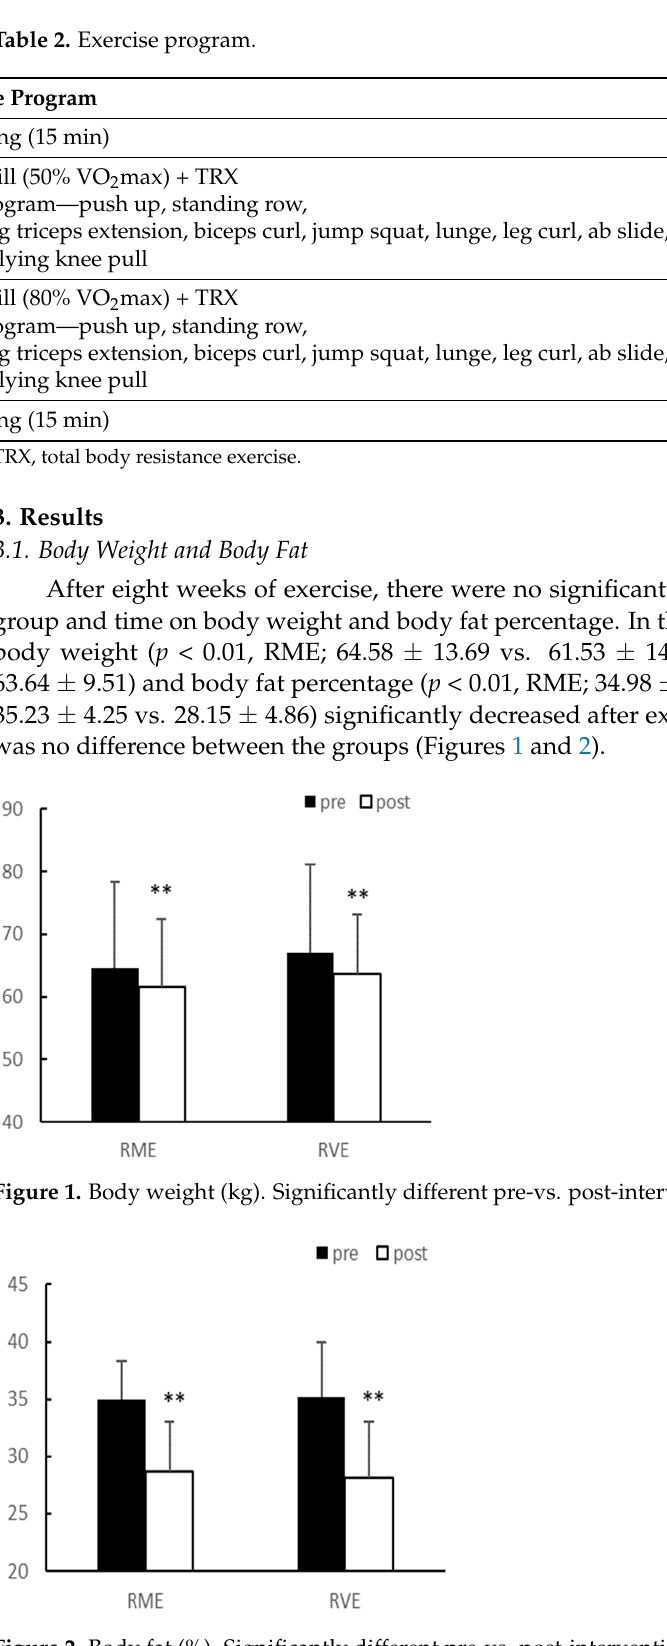
Figure 2. Body fat (%). Significantly different pre-vs. post-intervention at ** p < 0.01.